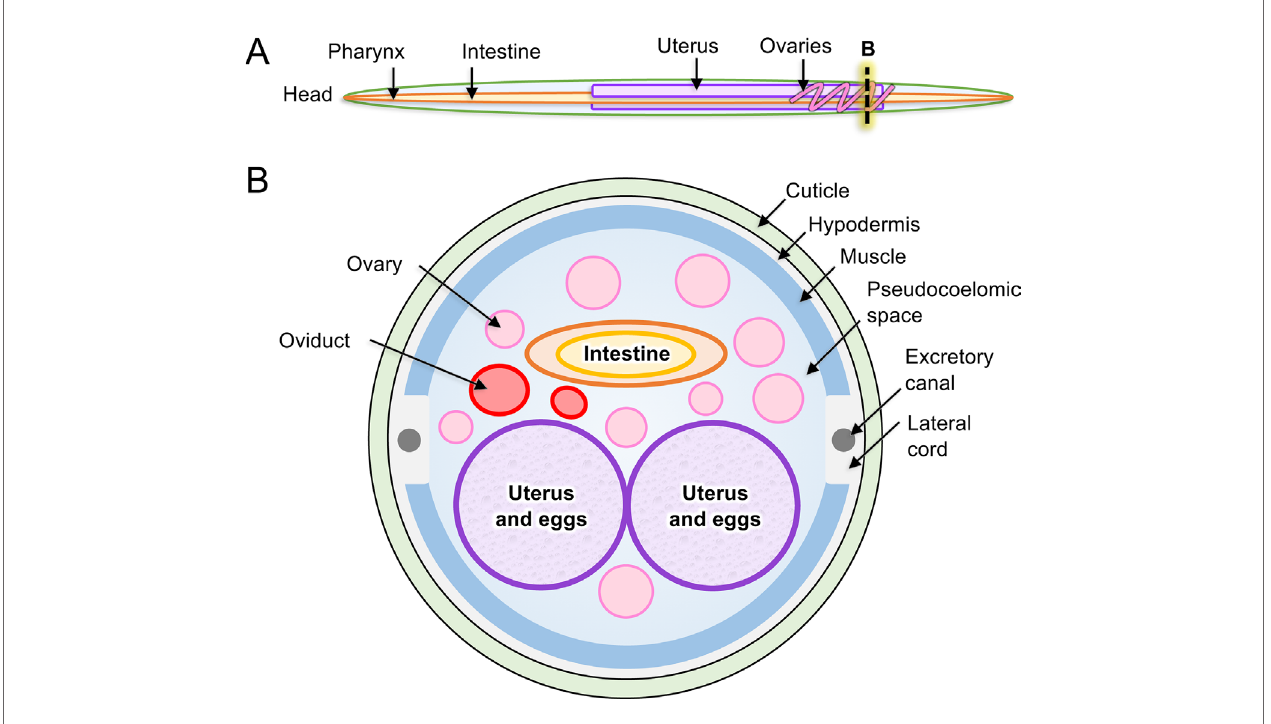
FIGURE 2 | Anatomy of model intestinal nematode species Ascaris suum . (A) Major organs are identified in an adult A. suum female worm, including (B) in